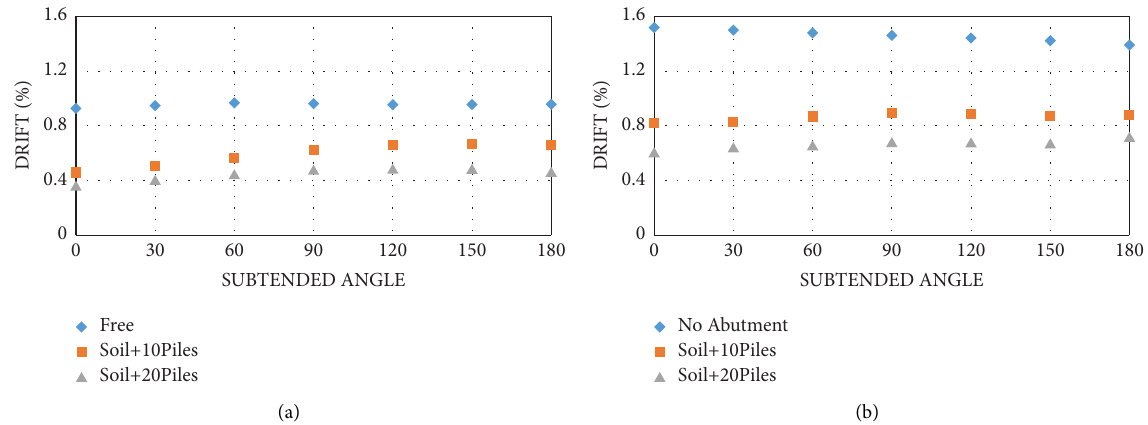
Figure 18: Drift demands of side columns in all bridge confgurations in the tangential direction using GMs compatible to (a) DBE and (b) MCE response spectrums.